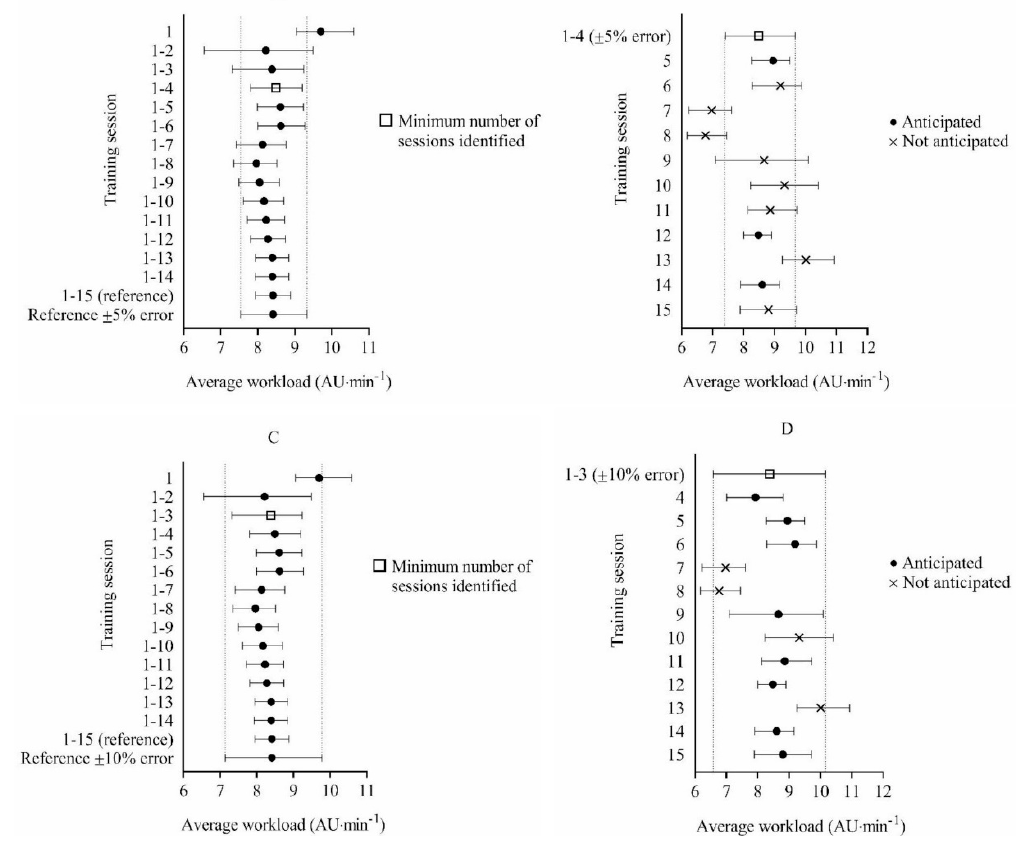
Figure 2. Bootstrap mean workload and bias-corrected 95% confidence intervals (CI) for determining